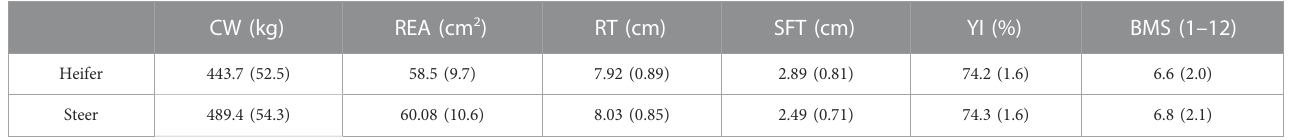
TABLE 1 The average values of studied phenotypes.